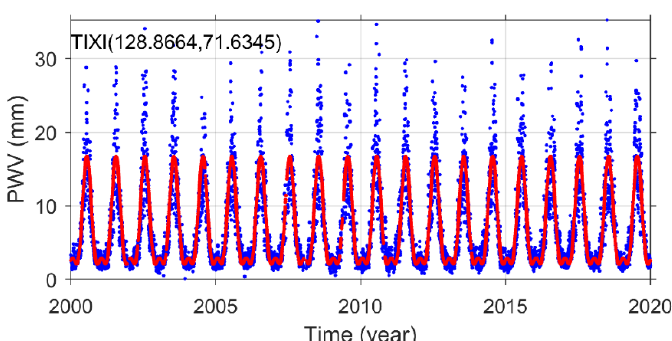
Figure A1. PWV time series (blue dots) and its fitting (red line) from the GNSS station TIXI.